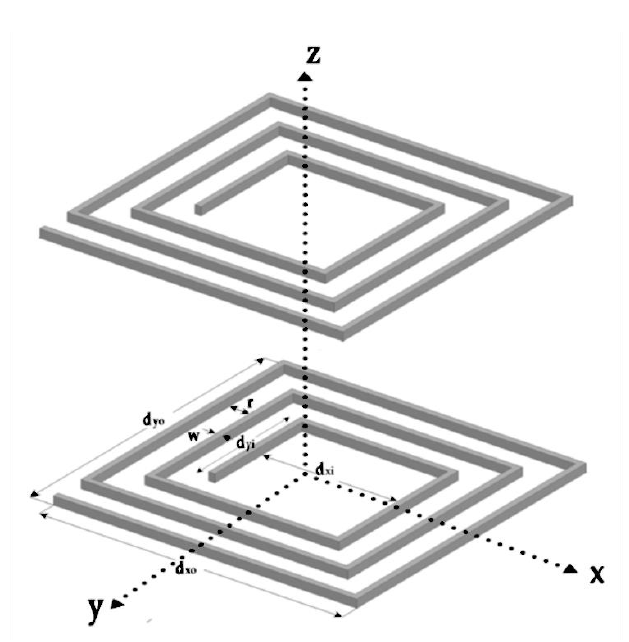
Figure 4. Diagram of the rectangular coils between primary and secondary windings of the WPT system.